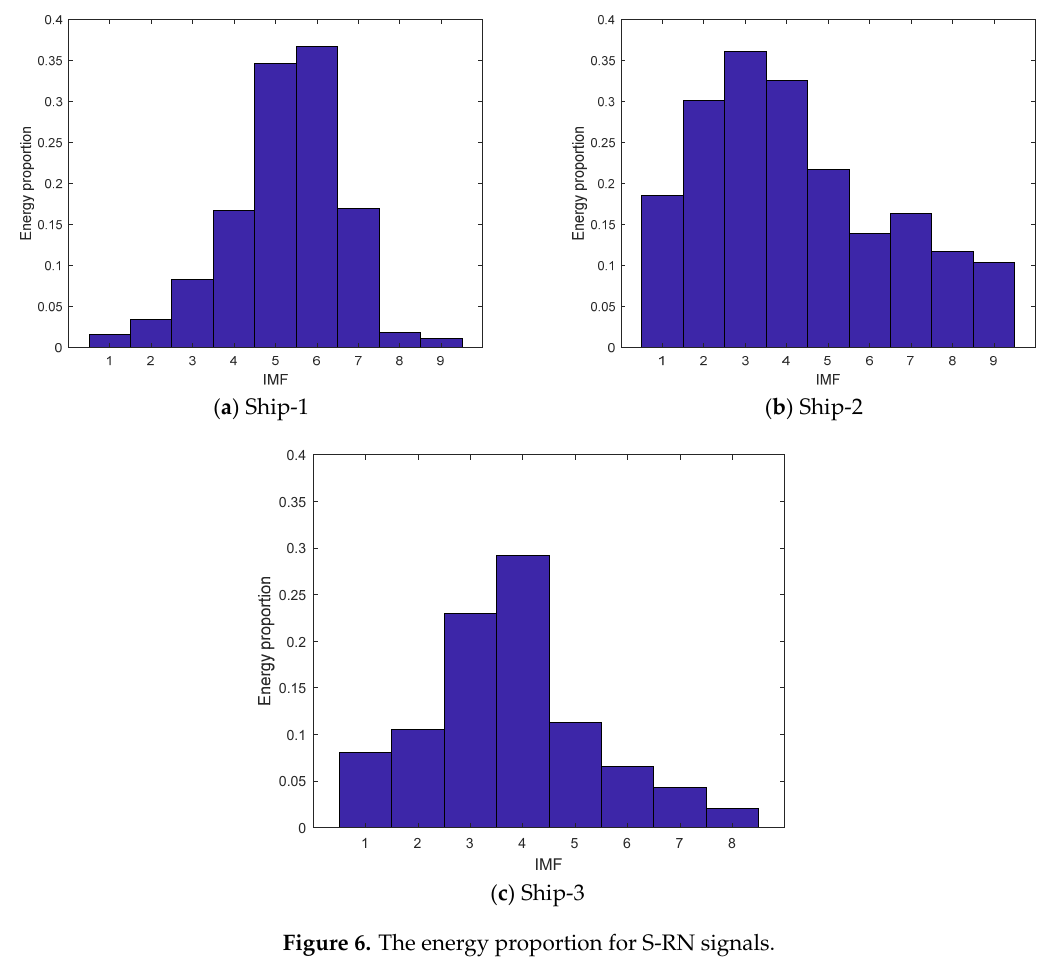
Figure 6. The energy proportion for S-RN signals. Table 2. The EE for S-RN signals. EE: energy entropy.